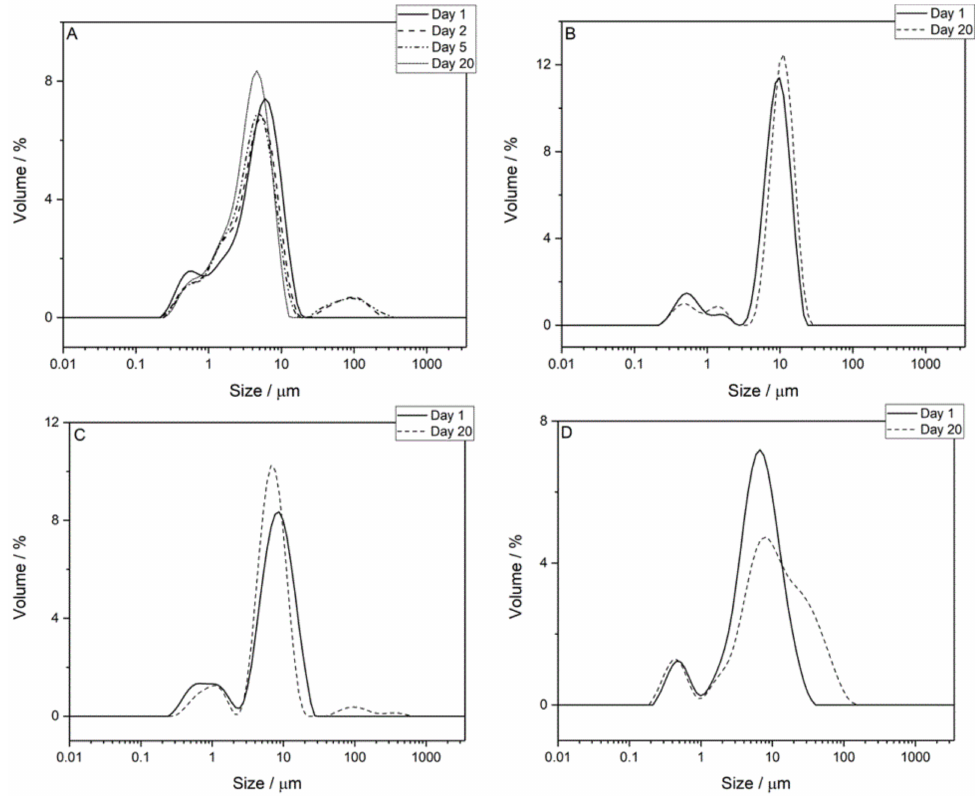
Figure 2. Representative droplet size distributions for: ( A ) 0.1 M citrate buffer; ( B ) 0.1167 M adipic acid; ( C ) 0.35 M KCl; and ( D ) 0.0075 M KCl. Data for days 1, 2, 5, and 20 are shown for the 0.1 M citrate buffer emulsion, and data for days 1 and 20 are shown for the 0.1167 M adipic acid, 0.35 M KCl, and 0.0075 M KCl